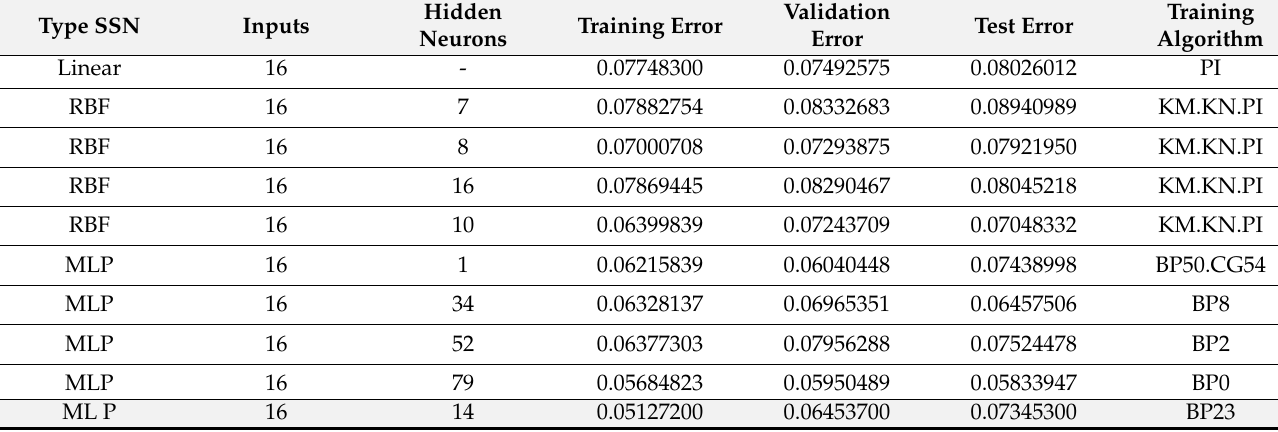
Table 3. A set of the best 10 generated neural